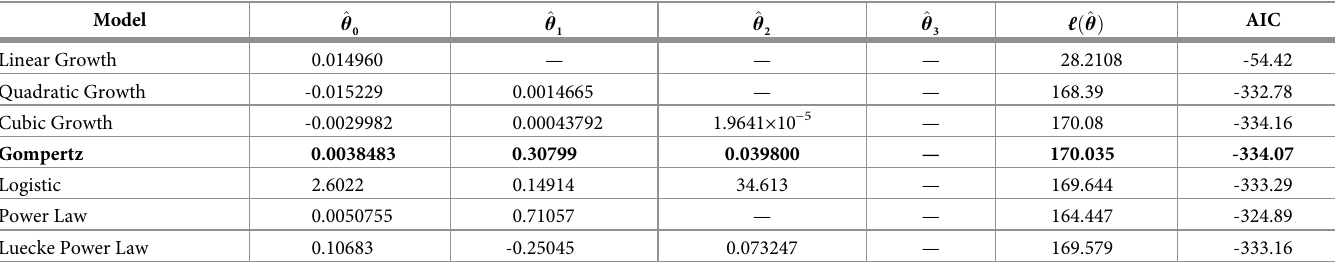
Table 22. Fetal thyroid mass models (g vs. fetal mass in g for power law models, g vs. gestational age in weeks for all other models).